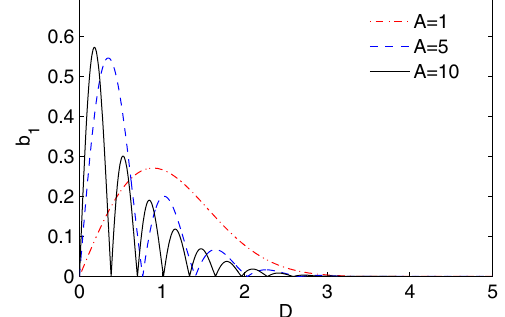
FIG. 4. The fundamental bunching factors as a function of the delay chicane strengths for different energy modulation amplitudes.